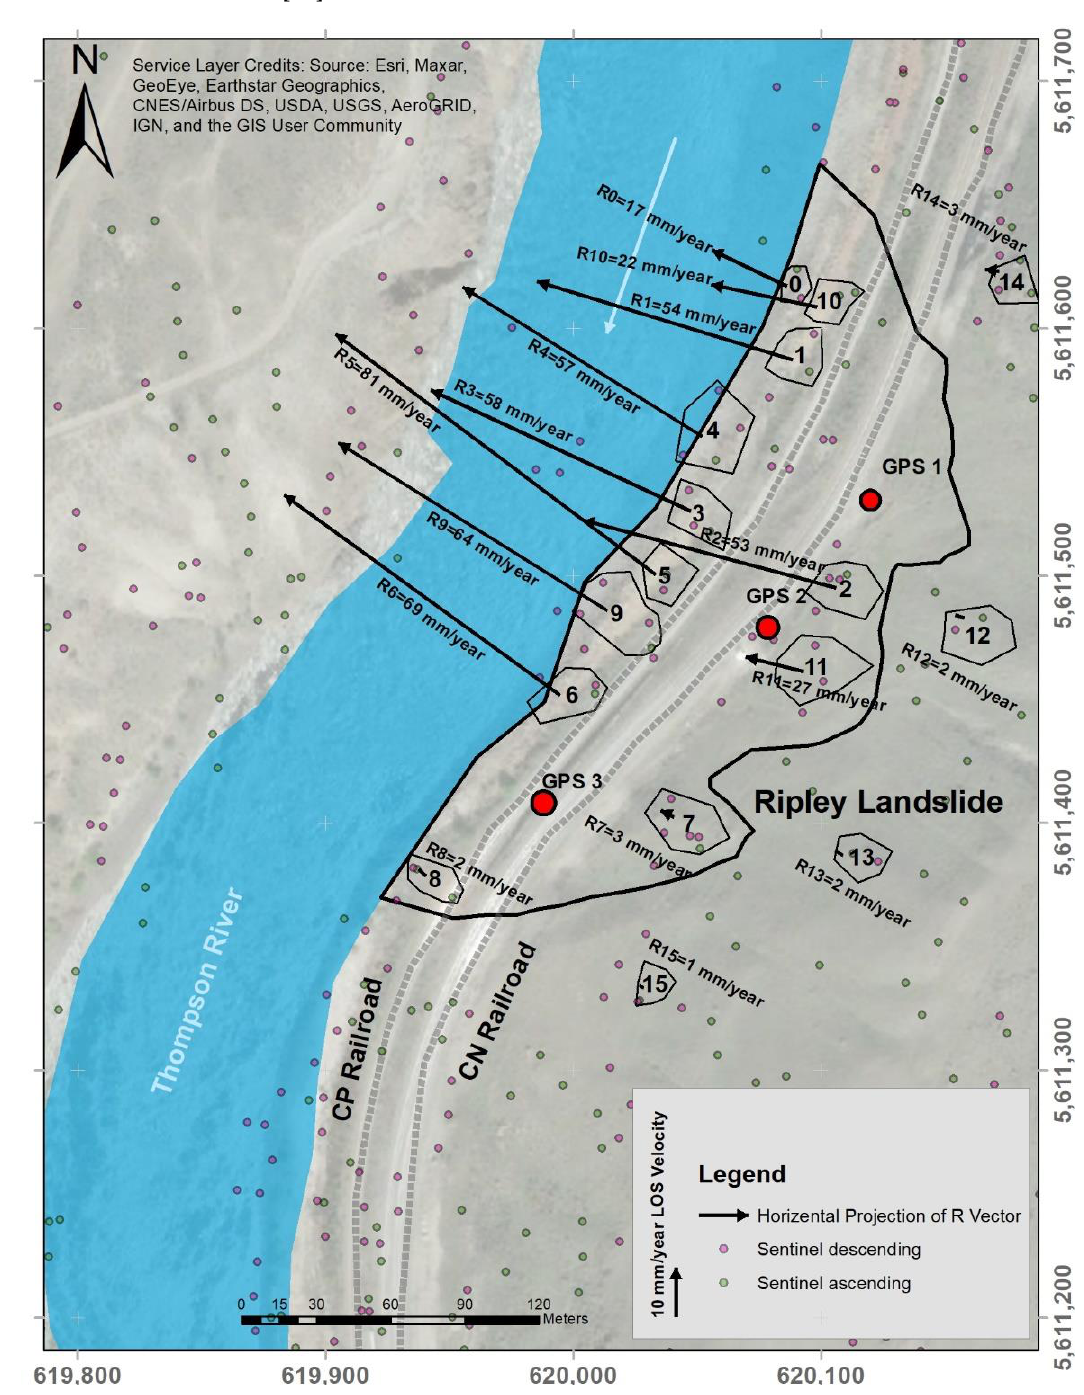
Figure 8. Calculated total horizontal component of deformation ( R ) in plan-view on Ripley land- slide.